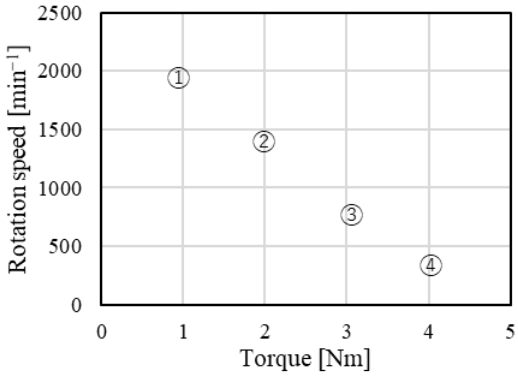
Figure 5. Outline of benchmark motor model: ( a ) benchmark motor model; ( b ) motor drive circuit.